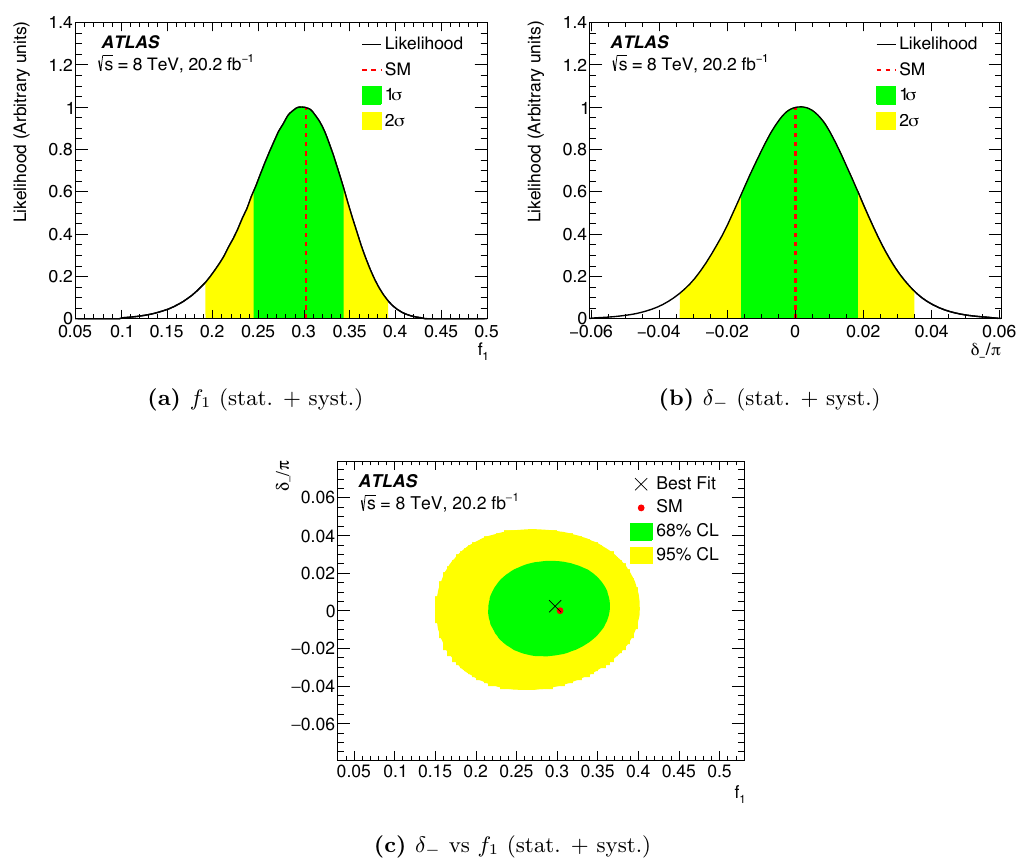
are shown. The black (cid:0) as a function (cid:0)